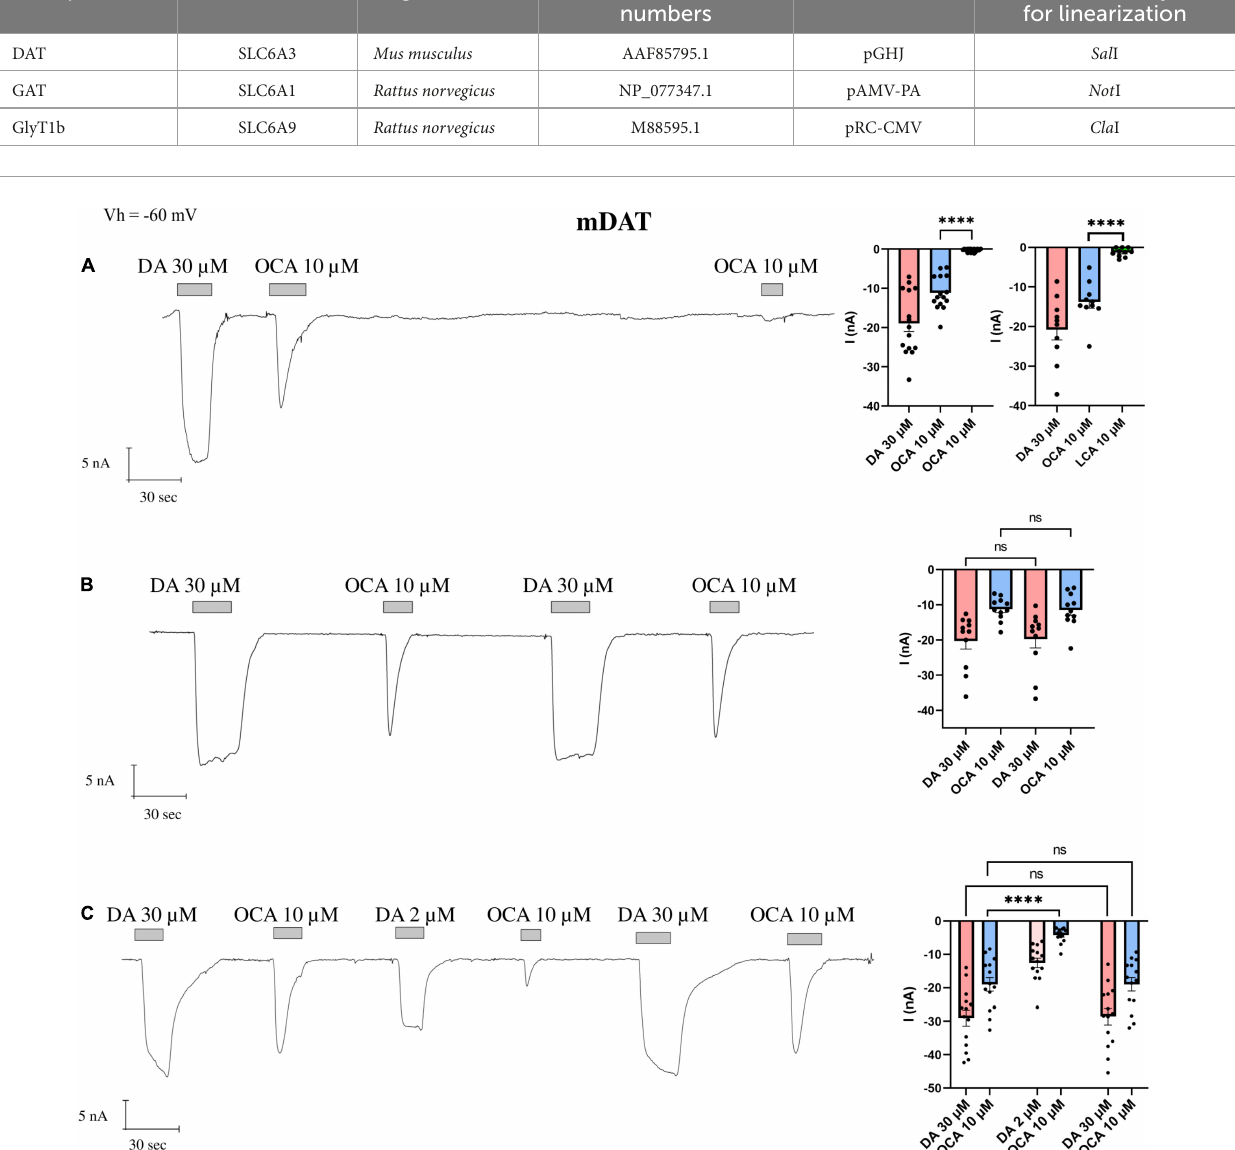
TABLE 1 List of transporter gene and vector characteristics, along with molecular methodology used to get the cRNA for oocytes injection. Transporter